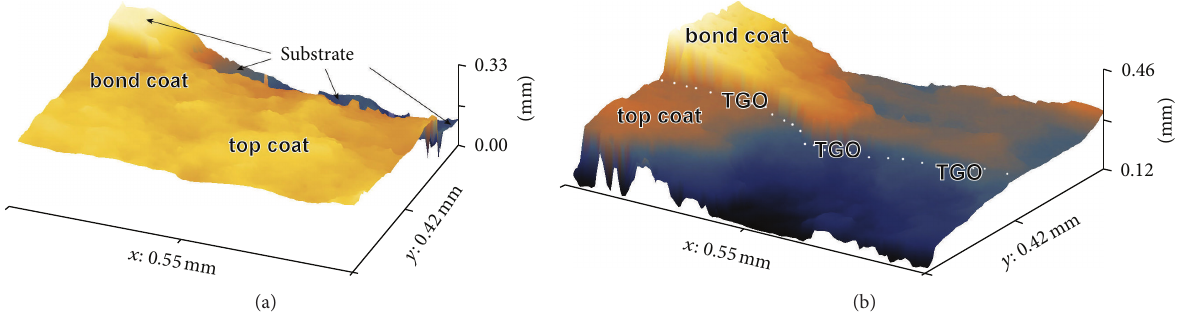
Figure 8: 3D view of initiation sites in specimens with TBCs subjected to pure bending: (a) as-sprayed specimen ( 𝑁 𝑓 = 1.3×10 5 cycles) and (b) oxidized specimen with ∼ 5 𝜇 m thick TGO layer between the bond coat and the top coat ( 𝑁 𝑓 = 8.6 × 10 5